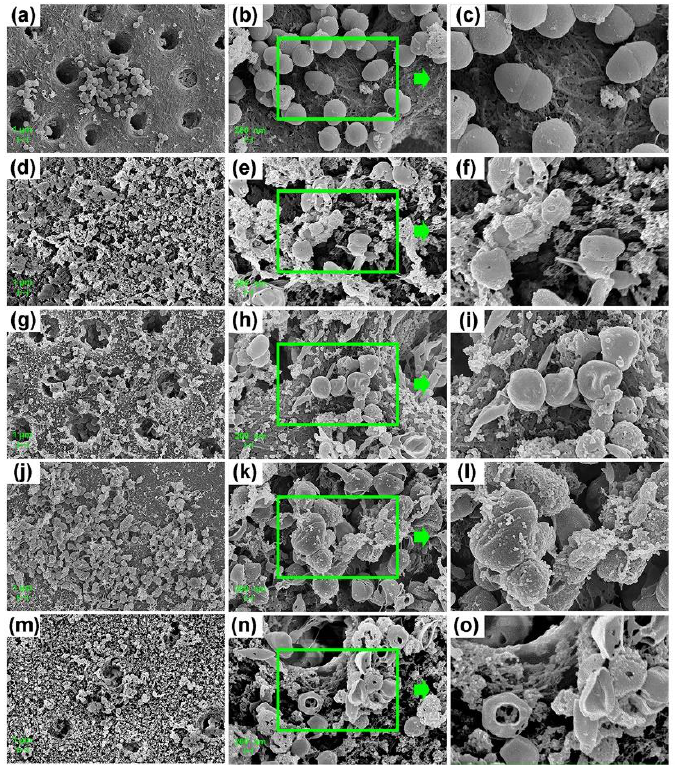
Figure 3. FE-SEM images of dentin biofilm in normal BHI. ( a – c ) Biofilm treated with PBS gel (blank control); ( d – f ) Biofilm treated with 0.04% TX-100 gel; ( g – i ) Biofilm treated with 100 mg/mL Met gel; ( j – l ) Biofilm treated with 2% CHX gel; ( m – o ) Biofilm treated with synergistic gel (0.04% TX-100 + 100 mg/mL Met) (magnifications are 5000×; 20,000×; zoom in).